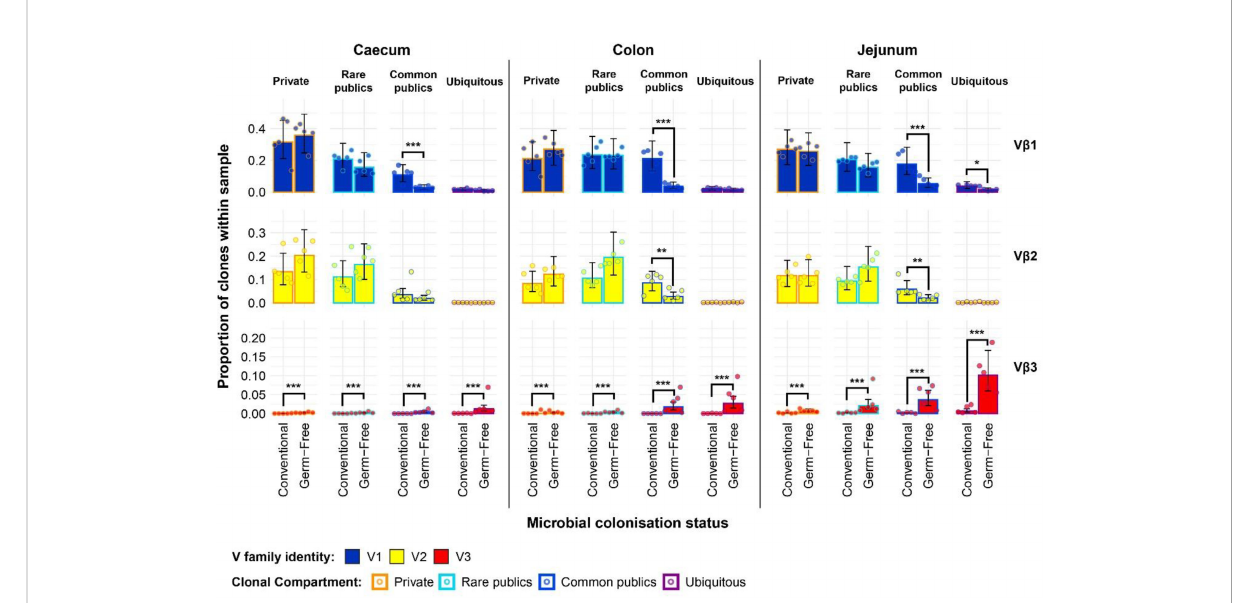
FIGURE 10 TCR b clone V family private and public compartments in the intestinal tissues based on different levels of clonal sharing between birds. Private (individual-restricted) clones are outlined in orange. Rare publics (shared between >2 individuals up to 5) and are outlined in light blue. Common publics (shared between >5 and up to 9 birds) are outlined in dark blue. Ubiquitous publics (found in all birds which were incorporated in the analysis) are outlined in purple. V family identities are shown in blue (V b 1), yellow (V b 2), and red (V b 3). Dots represent individual bird observations of V family contributions to the public and private clonal compartments. Error bars show the 95% bootstrap con fi dence intervals for the point estimates generated from 1000 simulations of the model. Statistically signi fi cant differences between the model estimates are depicted above the plots based ontheir corresponding p-values: *p < 0.05; **p < 0.01, ***p <